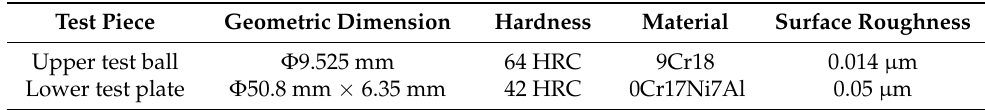
Figure 4. The experimental parameters are shown in Table